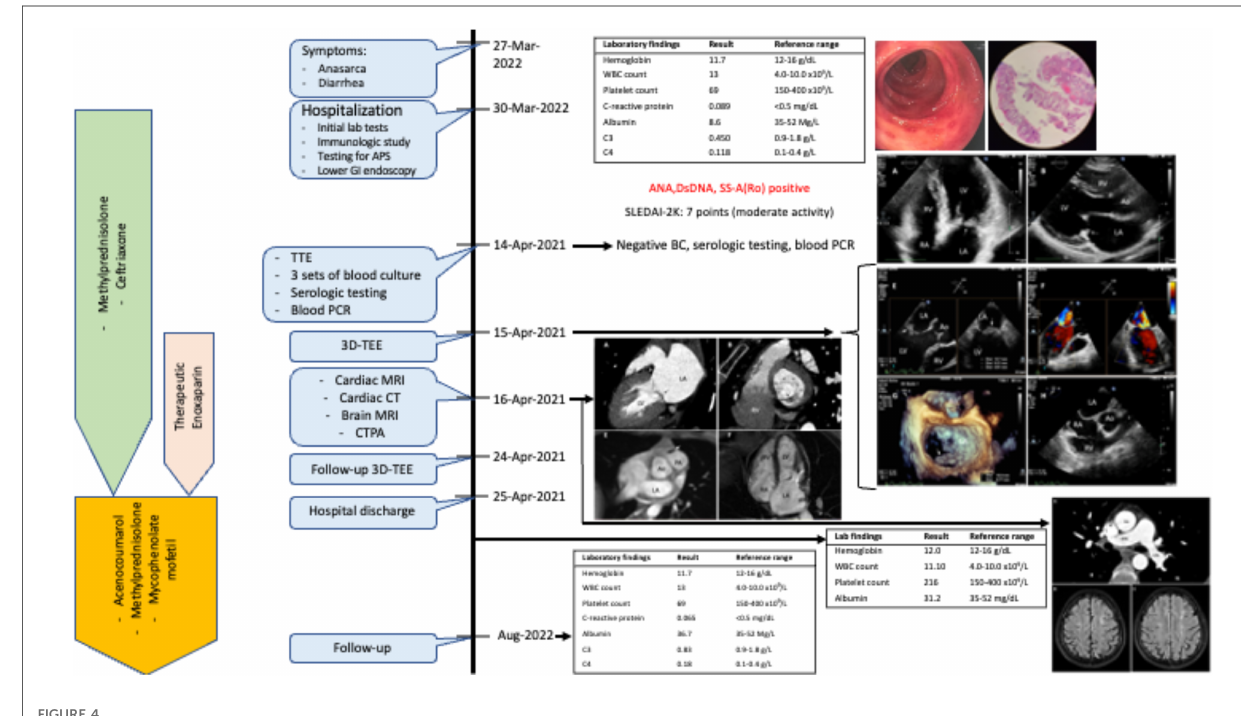
FIGURE 4 Timeline of patient clinical